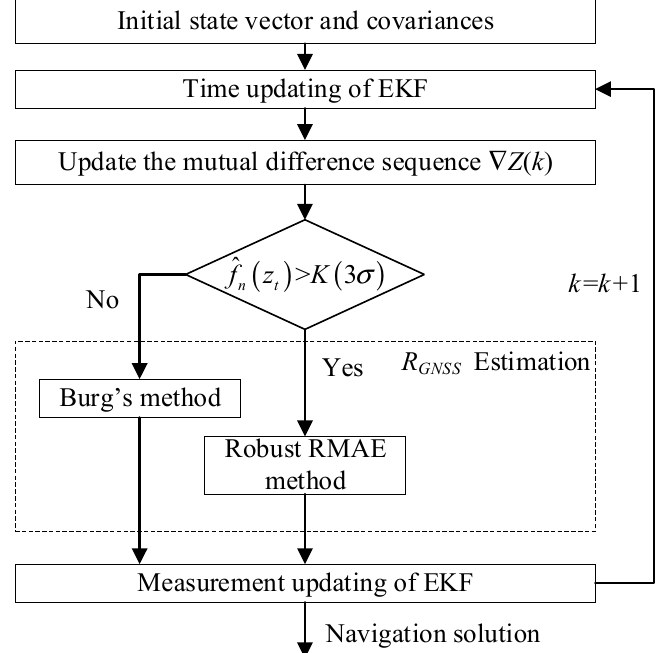
Figure 2. Diagram of the proposed enhanced redundant measurement-based adaptive Kalman filter (AKF).